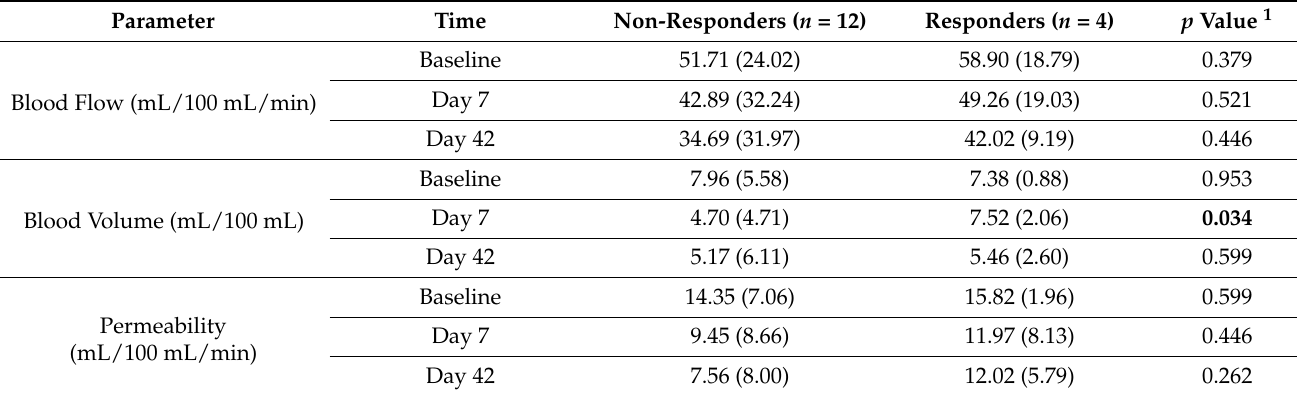
Table 5. Perfusion parameters in non-responder and responder patients. Mean values are shown, with the standard deviation in parentheses.